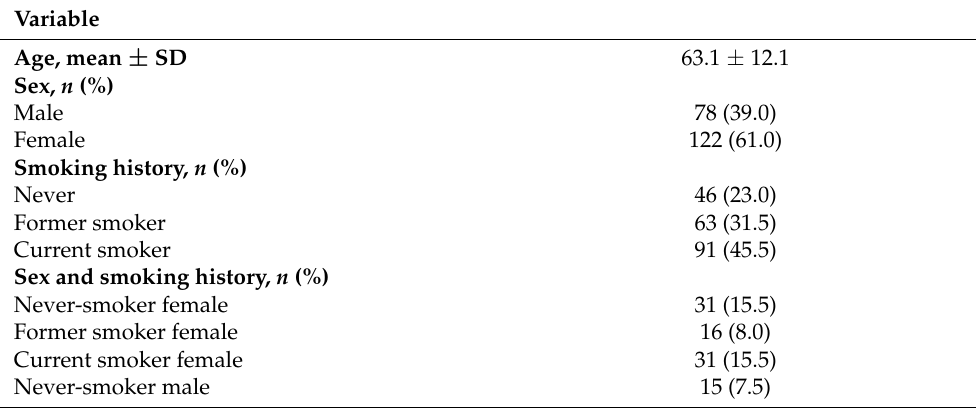
Table 3. Epidemiological and clinical–pathological characteristics of patients with stage IV